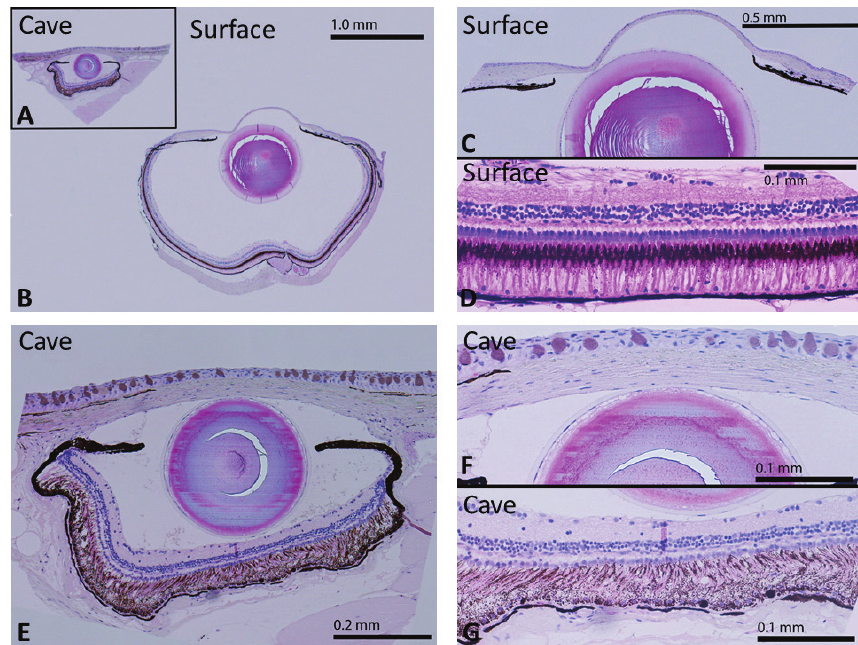
Figure 4. Cross section of the eye from Astroblepus pholeter ( A, E–G ) and Chaetostoma microps ( B–D ). Notice that the pigmented epithelium ( G ) and iris of A. pholeter ( E ) are black, implying that they are not albino. Furthermore, A. pholeter eye has retained its lens, optic nerve, and its retina has all the normal layers, as the surface fish